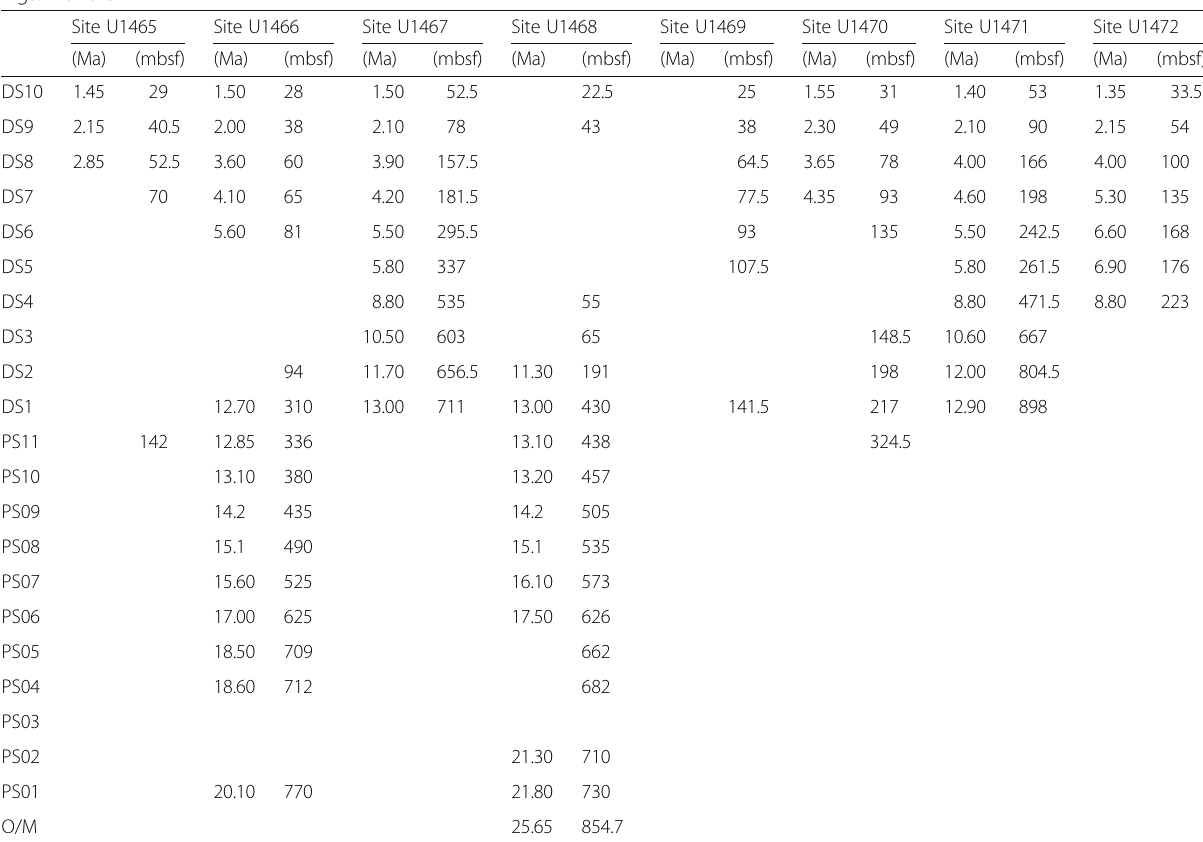
Table 2 Depths and ages of sequence boundaries at sites cored during IODP Exp. 359. Positions of these horizons are shown in Figs. 4 and